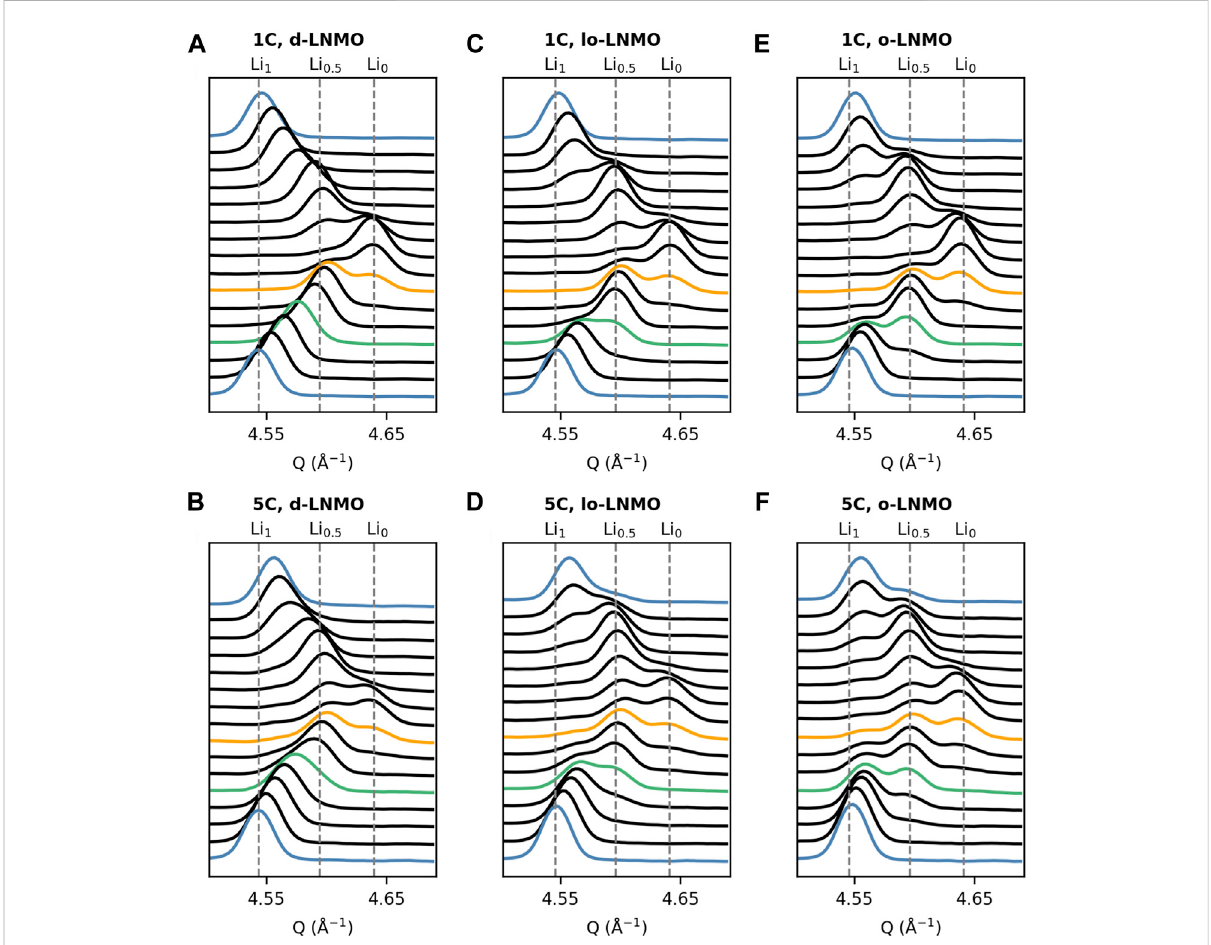
FIGURE 3 Plot of individual X-ray diffraction patterns in the region of the (531) re fl ection during galvanostatic cycling at 1C and 5C for (A – B) disordered LNMO (d-LNMO), (C – D) less ordered LNMO (lo-LNMO) and (E – F) ordered LNMO (o-LNMO). Patterns at beginning of charge and end of discharge are highlighted as blue. Patterns at a charge capacity of roughly 50 and 100 mAh g − 1 (corresponding to ≈ 1/3 and 2/3 SOC) are highlighted as green and yellow